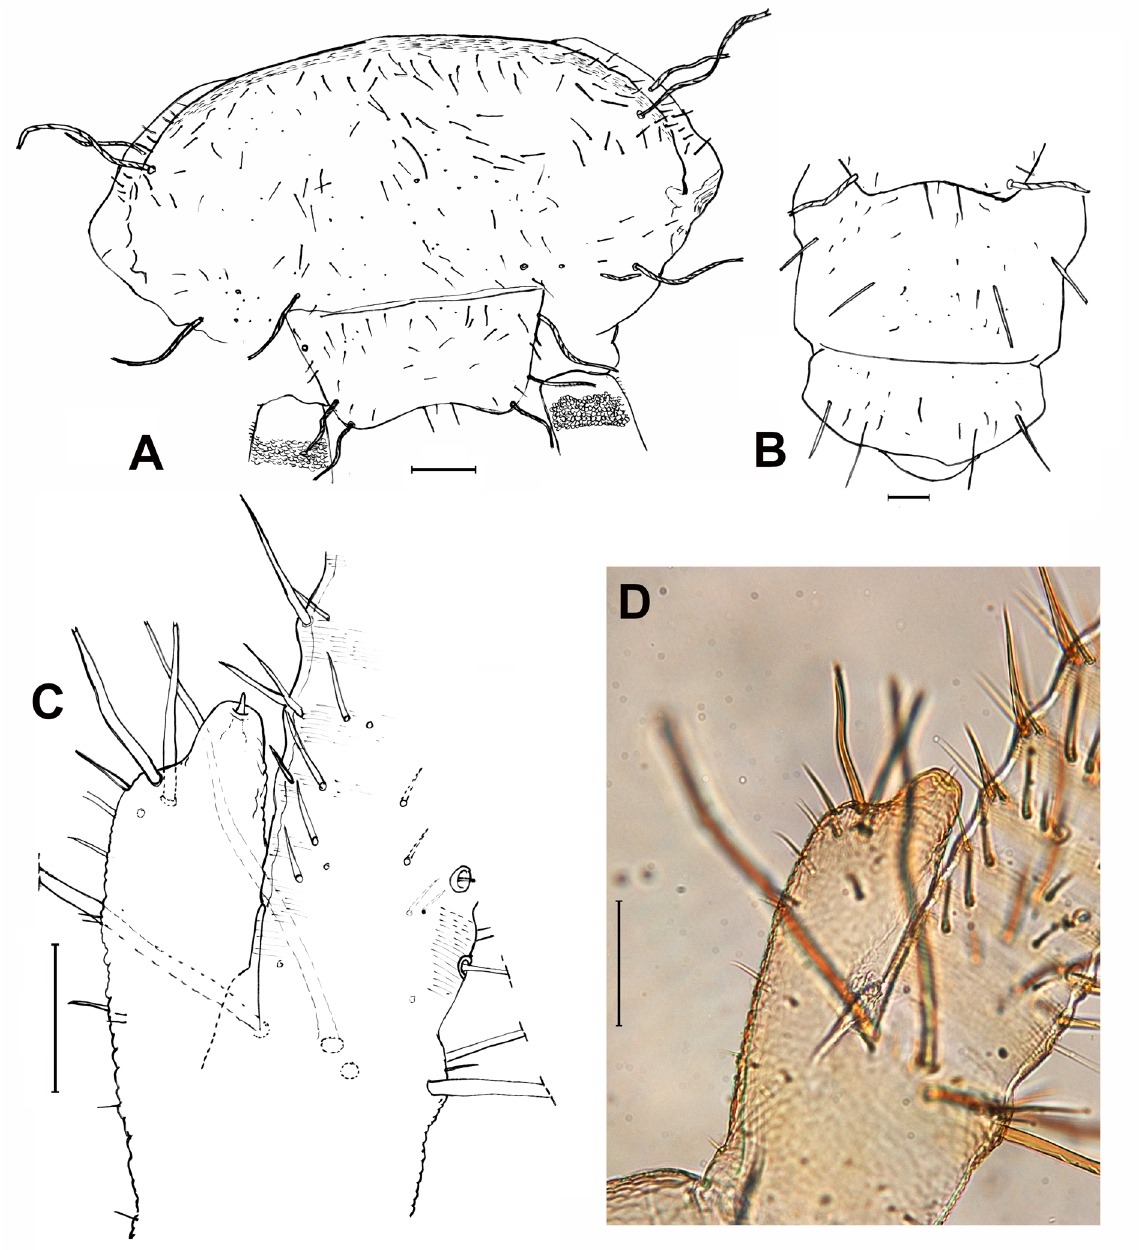
Fig. 2. Coletinia dalmatica Molero-Baltanás, Fišer, Bach de Roca & Gaju-Ricart sp. nov. Holotype, ♂ (MNCN_Ent 283558). A . Head and frons. B . Clypeus and labrum. C . Pedicellar apophysis. D . Micrograph of the same apophysis. Scale bars: A–C = 0.1 mm; D = 0.2